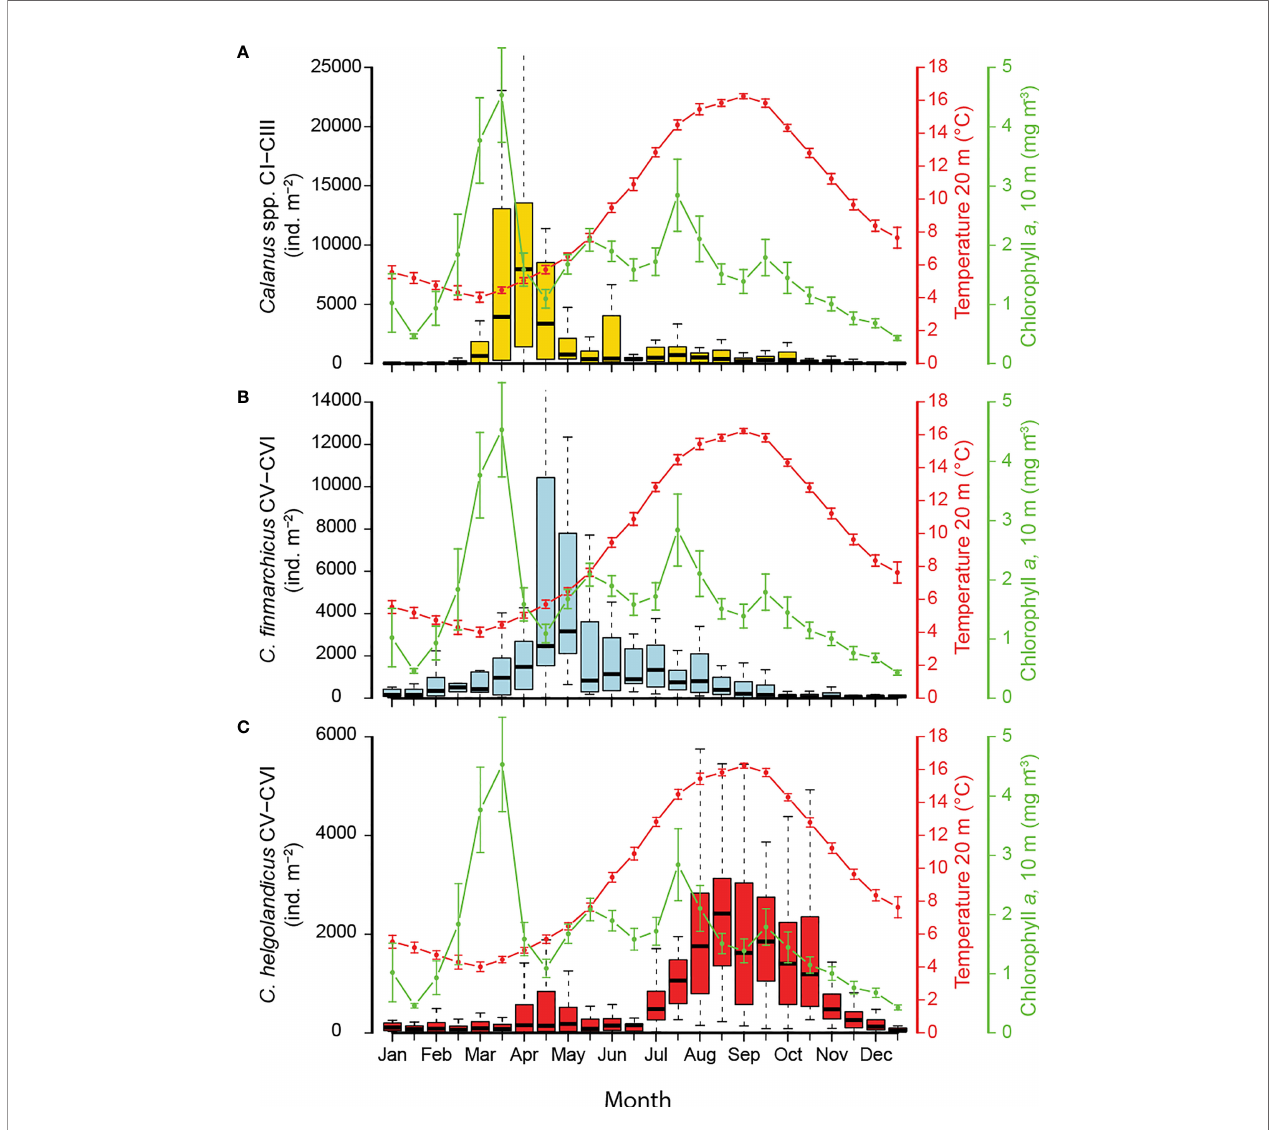
FIGURE 3 | Seasonal pattern in abundances at 0-50 m depth of (A) Calanus spp. CI-CIII (B) , C. fi nmarchicus CV-VI and (C) C. helgolandicus CV-VI. Lower and upper edges of boxes represent the 25 and 75 percentiles, and the horizontal lines the medians. Extreme observations outside the range of the whiskers are not shown. Seasonal variation in temperature (20 m, mean and standard error, SE) and Chl- a (10 m, mean and SE) on right axis. Data on temperature and Chl-a were obtained from the Norwegian Coastal Monitoring